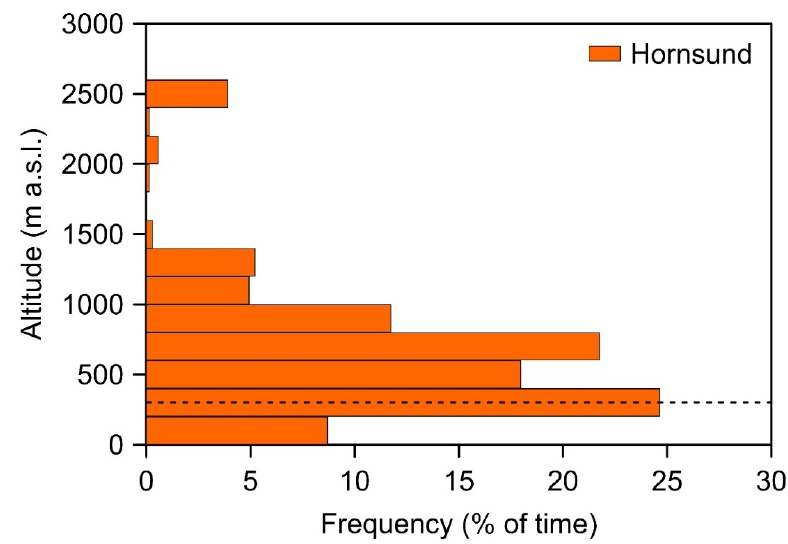
Figure 6. Cloud base height frequencies at Hornsund in the period 1 March–26 June 2019.